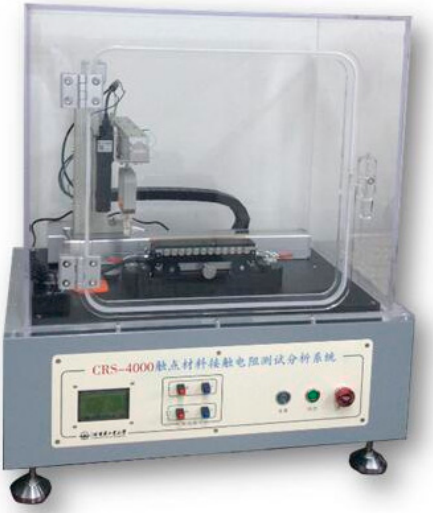
Figure 3. Appearance of the designed instrument.